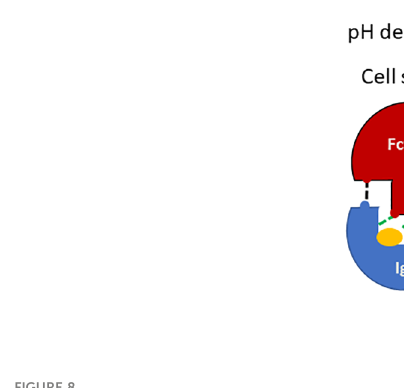
FIGURE 8 A cartoon showing the pH dependent IgG binding and release by Fc g